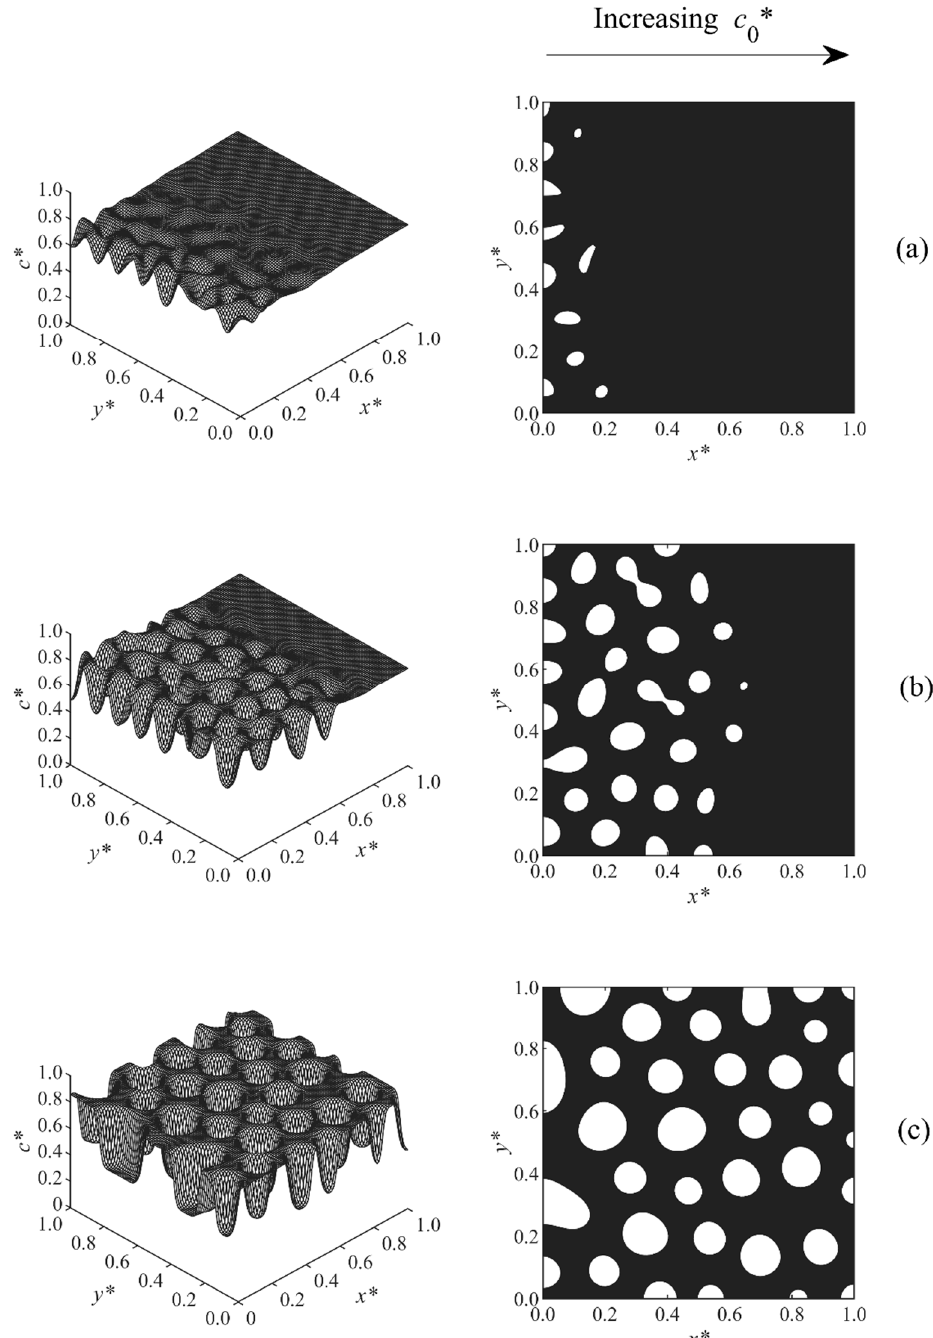
Figure 4. Spatial concentration profiles (first column) and phase-separated patterns (second column) for Case 3 at the following times: ( a ) t ∗ = 1.01 × 10 − 4 , ( b ) t ∗ = 1.02 × 10 − 4 , ( c ) t ∗ = 1.07 × 10 − 4